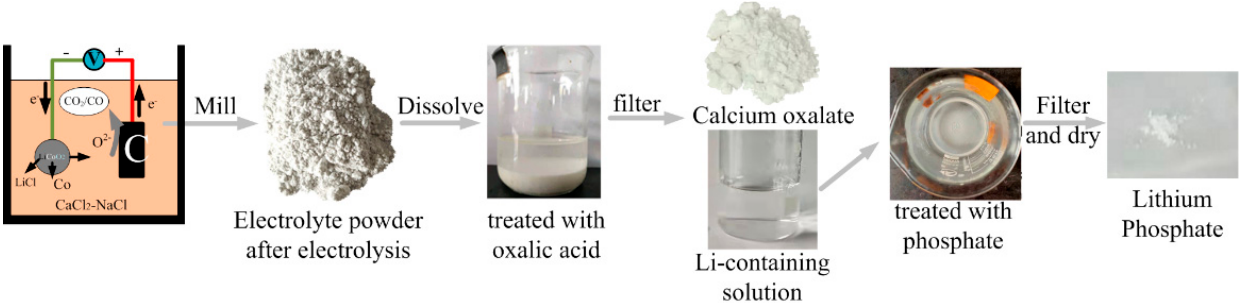
Figure 1. Schematic diagram of two-step lithium extraction.